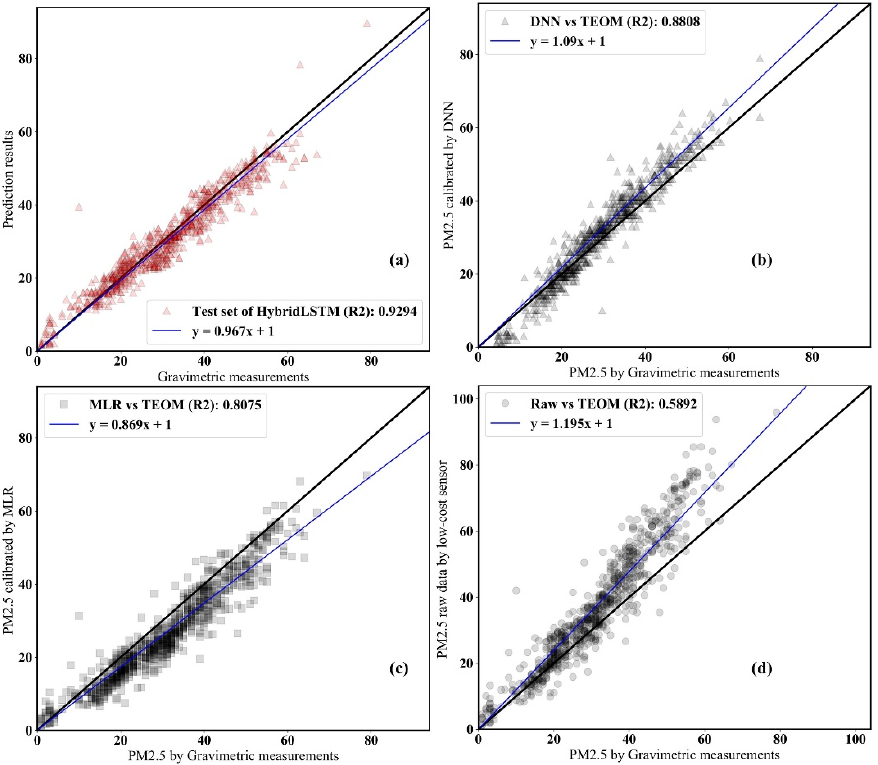
Figure 8. Results of scatter plot for the HybridLSTM ( a ), benchmark ( b ) and raw data ( c ) versus gravimetric measurements ( d ).